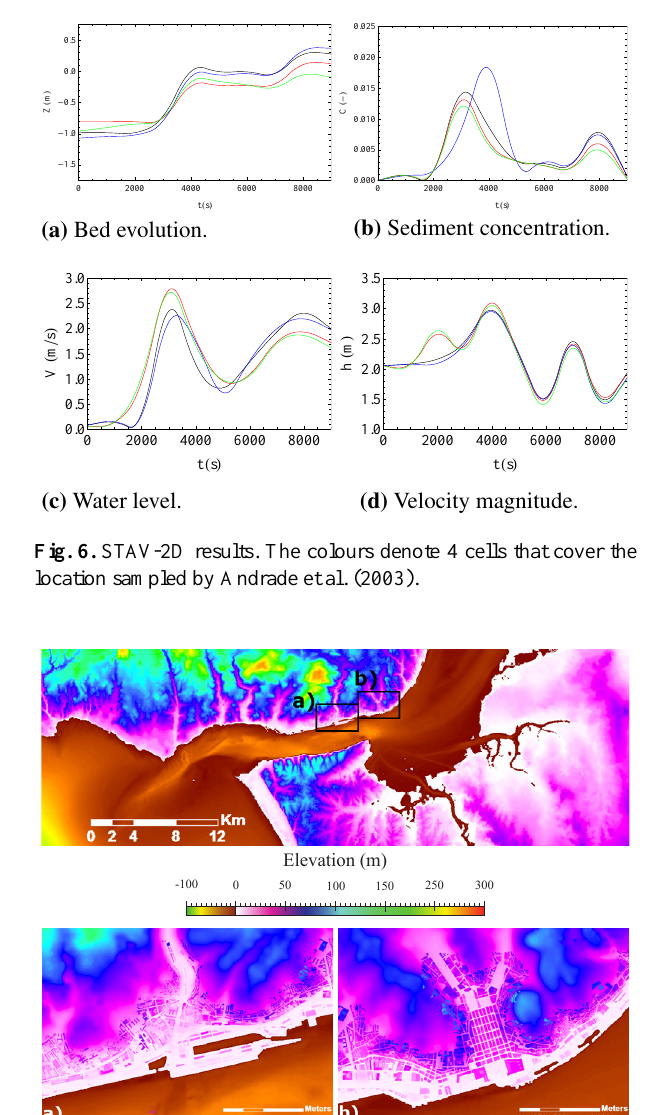
Fig. 7: Digital Elevation Model. Top: Overview of the Tagus